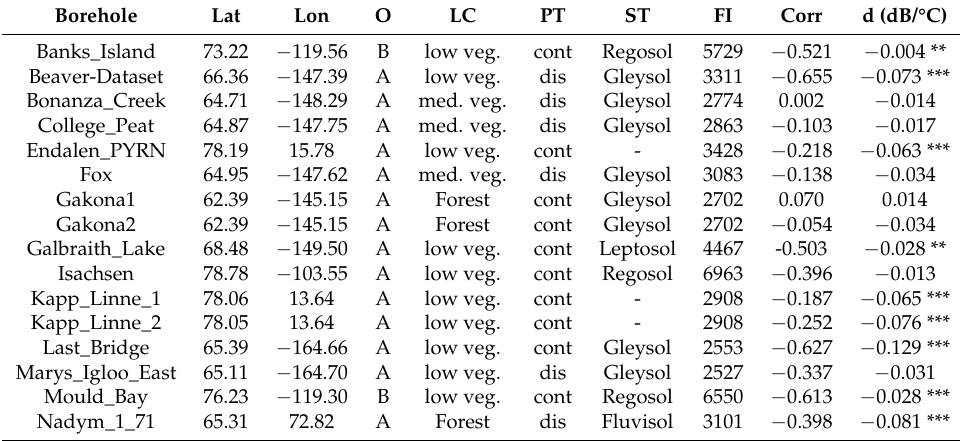
Table 2. Overview of GTN–P boreholes and the Orbits (O) for ASCAT measurements (A, Ascending; D, Descending; and B, average from both), Landcover (LC), Permafrst type (PT), Soil type (ST), long–term average freezing index in degree–days (FI), average pearson correlation for the upper 20 cm (Corr) and estimated parameters (d) for ground temperature with significance (*** (cid:98) = p < 0.01, ** (cid:98) = p < 0.05) level; Boreholes with no values for correlation and d lack sufficient measurements in the upper 20